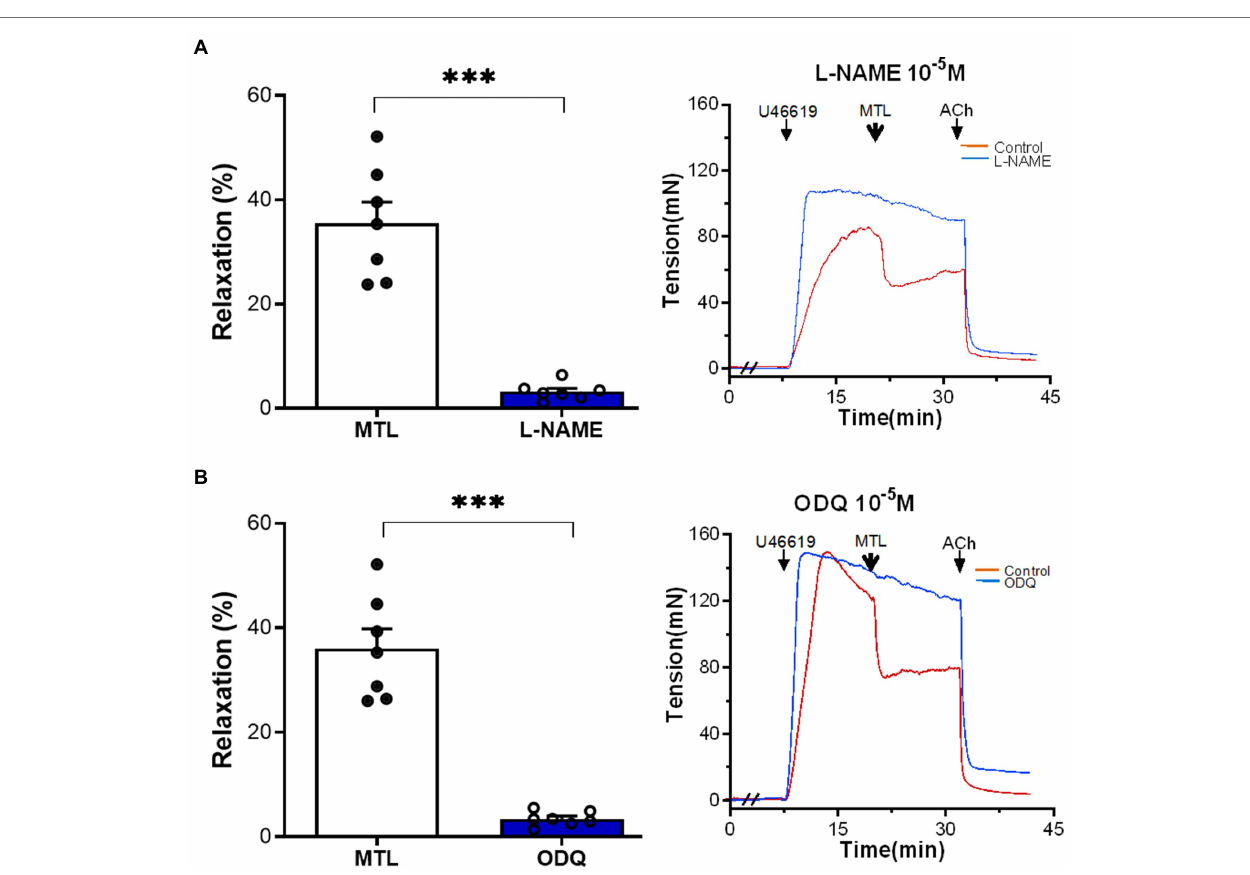
FIGURE 7 | Role of the NOS–NO–sGC–cGMP pathway on motilin-induced vasorelaxation. (A,B) Effects of L-NAME (10 − 4 M) and ODQ (10 − 5 M) on LGA relaxation induced by motilin (9 × 10 − 8 M) and corresponding representative traces. Values are means ± SEM ( n = 7). *** p < 0.001 by paired t -test. The double slash (//) indicates pretreatment with L-NAME and ODQ before incubation with U46619. The arrows indicate the time of drug administration. ACh, acetylcholine; cGMP, cyclic guanosine monophosphate; LGA, left gastric artery; L-NAME, N-nitro-L-arginine methyl ester (NOS inhibitor); MTL, motilin; NO, nitric oxide; NOS, nitric oxide synthase; ODQ, sGC inhibitor; SEM, standard error of the mean; sGC, soluble guanylyl cyclase; and U46619, thromboxane A 2 receptor